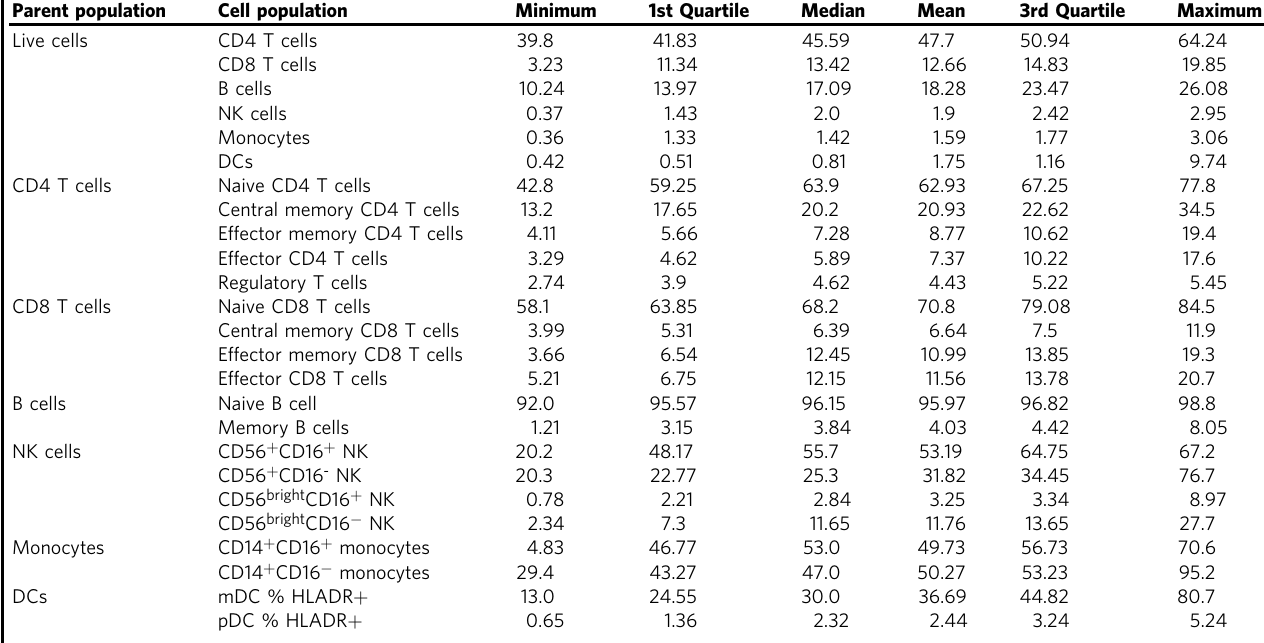
Table 2 Summary of cell frequencies (% of parent) by manual gating within the healthy infants (group NA, n = 12). Parent population Cell population Minimum Live